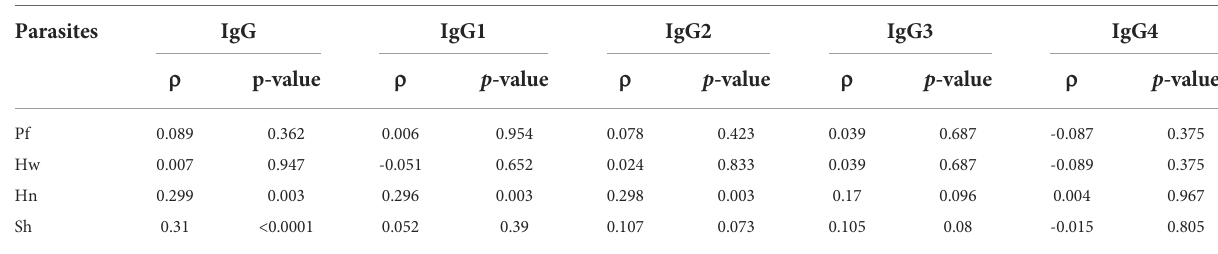
TABLE 2 Association between anti-GMZ2 antibodies and parasite load in children.